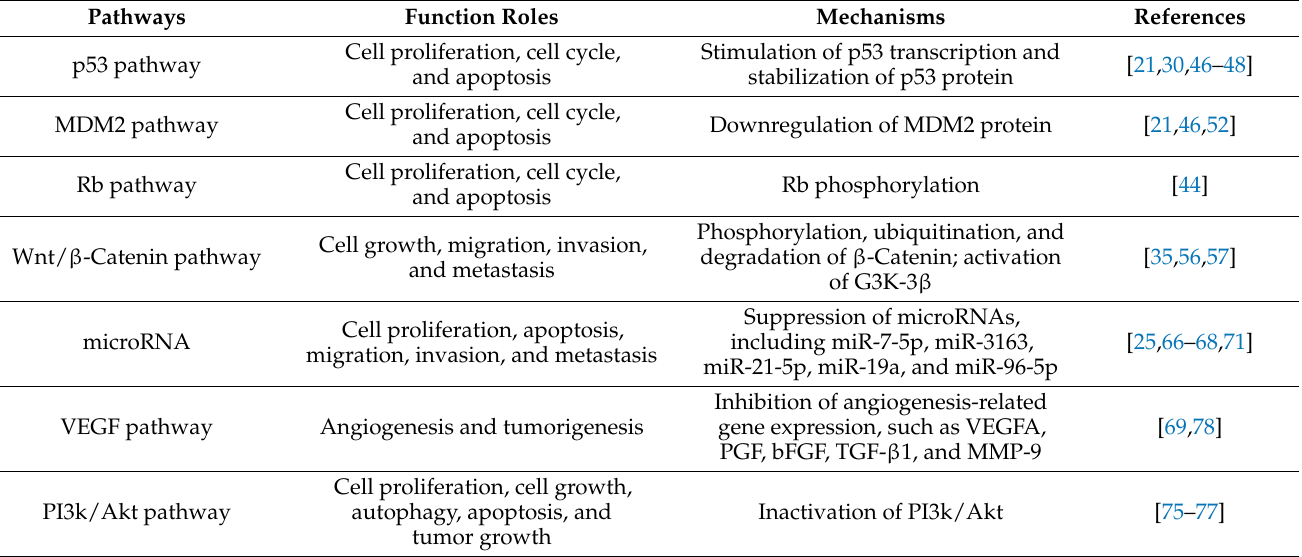
Table 1. The mechanisms of MEG3 in cancer development. MEG3 is involved in multiple processes of cancer development, such as cell proliferation, cell cycle, apoptosis, autophagy, angiogenesis, migration and invasion, tumor growth, and metastasis. The inhibitory effects of MEG3 on cancer are involved in various pathways, including p53, MDM2, Rb, Wnt/ β -catenin, microRNA, PI3K/Akt, VEGF, and many